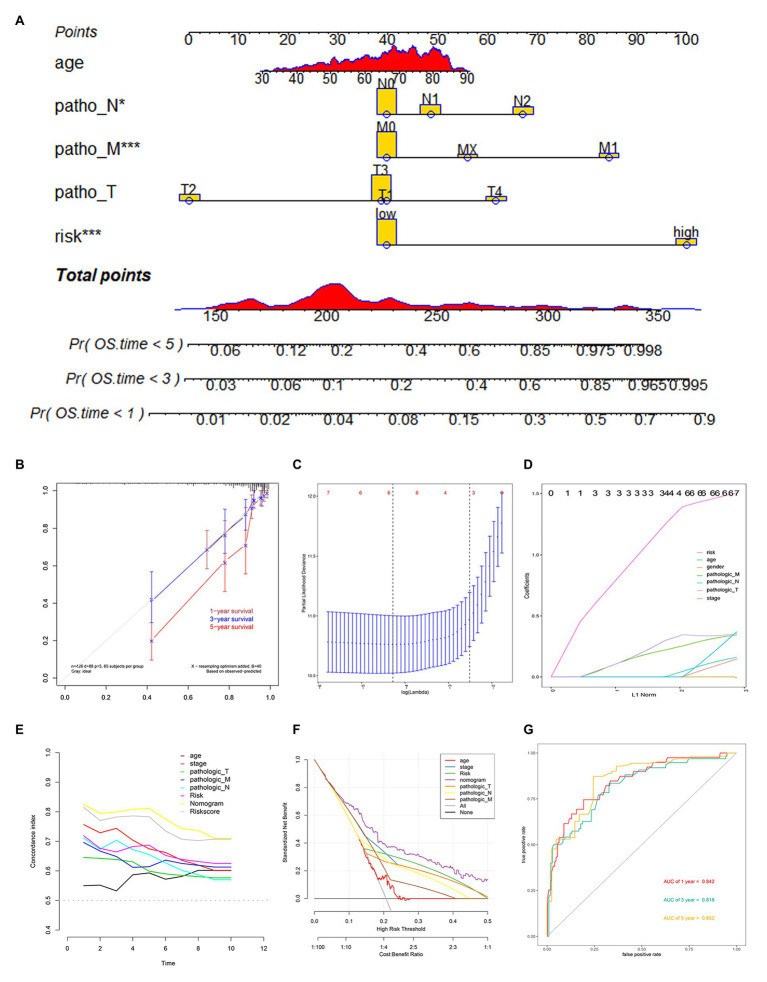
Nomogram construction based on 12-gene signature and prognostic value of 12 genes. (A) The nomogram for predicting the proportion of patients with 1-, 3-, or 5-year OS. (B) Calibration plots of the nomogram. (C,D) LASSO regression analysis used 10-fold cross-validation via the maximum criteria. (E) C-index of the nomogram (F) Decision curve analysis of nomogram predicting 1-, 3-, and 5-year OS of COAD comparing age, stage, the risk score, Pathologic T, Pathologic N, and Pathologic M. (G) Time-dependent ROC analysis of nomogram predicting 1-, 3-, and 5-year OS of COAD.